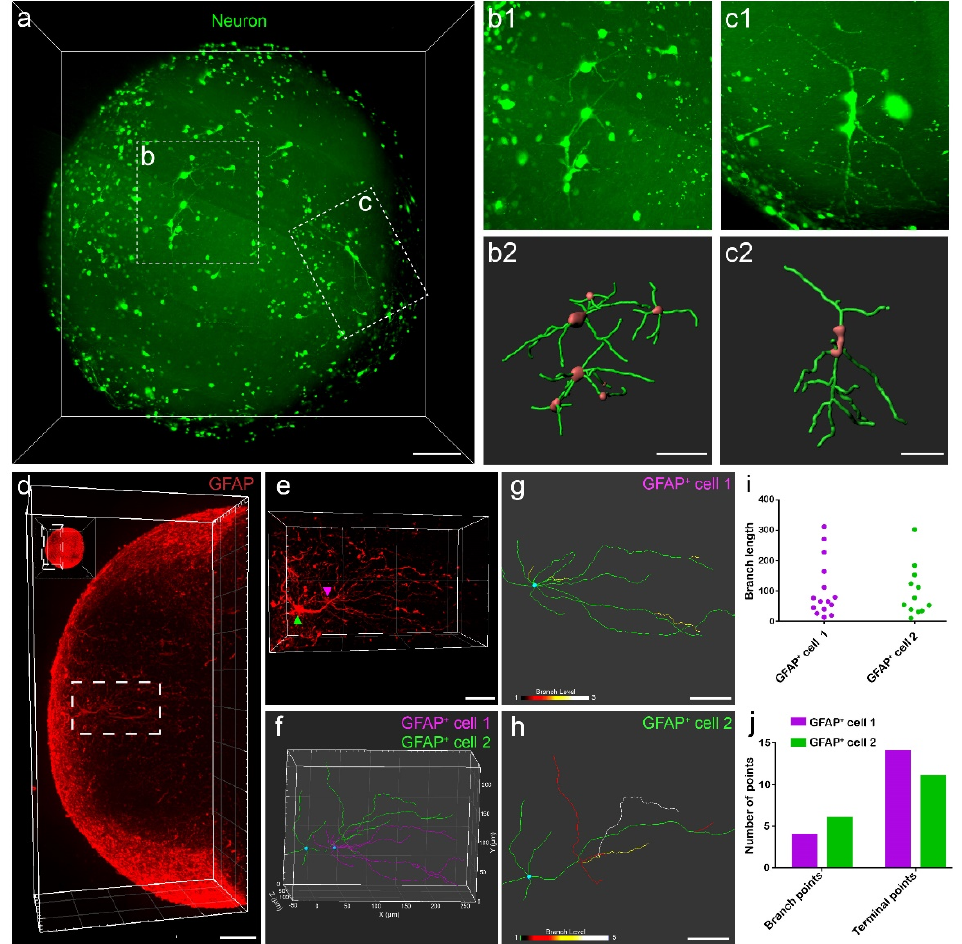
Figure 4. Three-dimensional imaging dataset of organoids enables single-cell reconstruction. ( a ) Three-dimensional view of neurons in cerebral organoids. Scale bar: 100 μ m. ( b1 , c1 ) Higher magnifications of specified regions in ( a ). ( b2 , c2 ) Neuron morphology reconstructed with Imaris software. Scale bar: 50 μ m. ( d ) Three-dimensional view of GFAP + cells in organoids. Scale bar: 100 μ m. ( e ) Higher magnifications of specified regions in d. Scale bar: 50 μ m. ( f ) Single-cell reconstruction of two GFAP + cells. ( g , h ) Branch level of each astrocyte. Scale bar: 50 μ m. ( i ) A scatter plot of their branch lengths of the two tracked GFAP + cells. ( j ) Histogram showing the numbers of branch points and terminal points of the two tracked GFAP + cells. Green fluorescent signals in all graphs in this figure denoted neurons, and the red fluorescent signals denoted GFAP + cells.